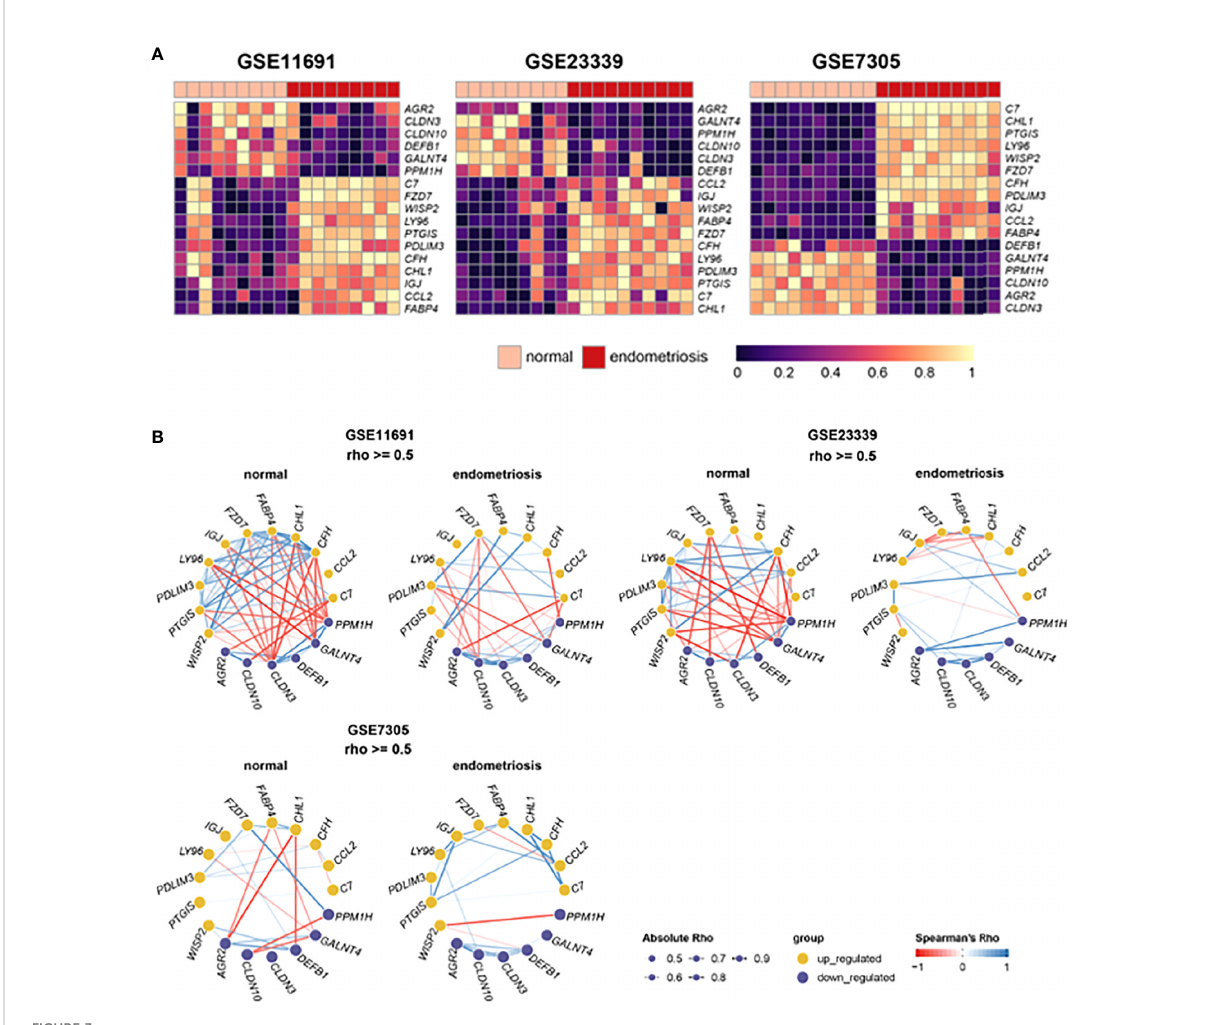
FIGURE 3 Expression and correlation of 22 DEGs with Log2|FC| > 2. (A) Heat maps show the expression levels of 22 DEGs in datasets, GSE11691, GSE23339, and GSE7305. (B) Gene networks display correlations of 22 DEGs in the normal and endometrial tissues of each dataset. The depth of edges indicates absolute Rho ranging from 0.5 to 1. The color of edges indicates co-expression ranging from -1 (red) to 1 (blue) by Spearman ’ s